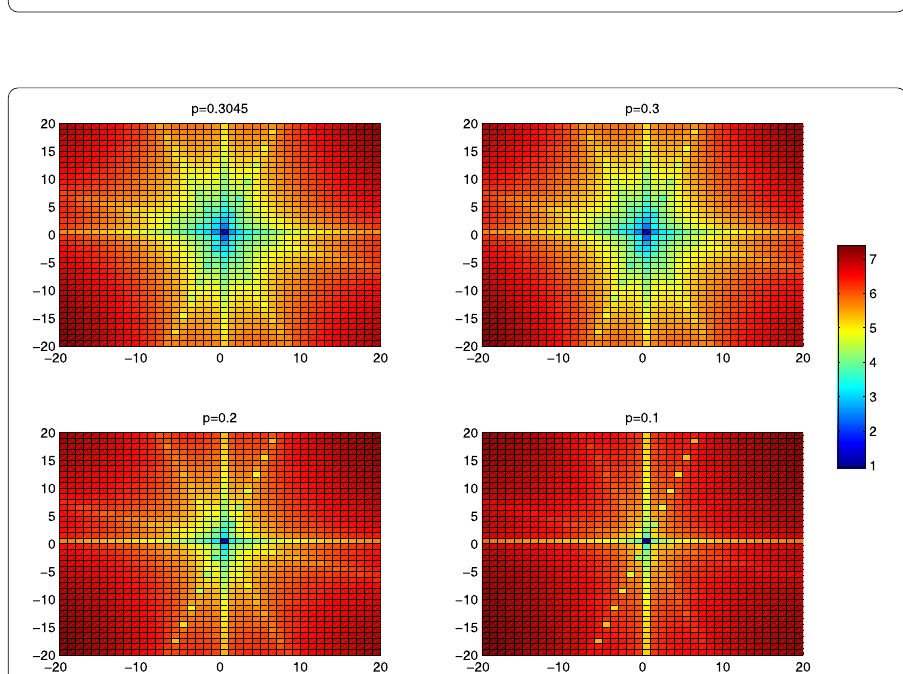
Figure 3 On s - t plane for the p -norm of the solutions to the different cases in Example 2.